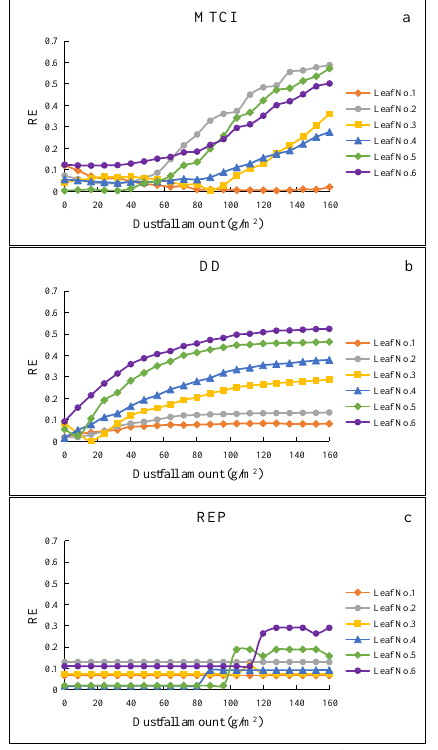
Fig. 2. Inversion accuracy varies with dustfall amount. (a) MTCI, (b) DD, (c) REP.